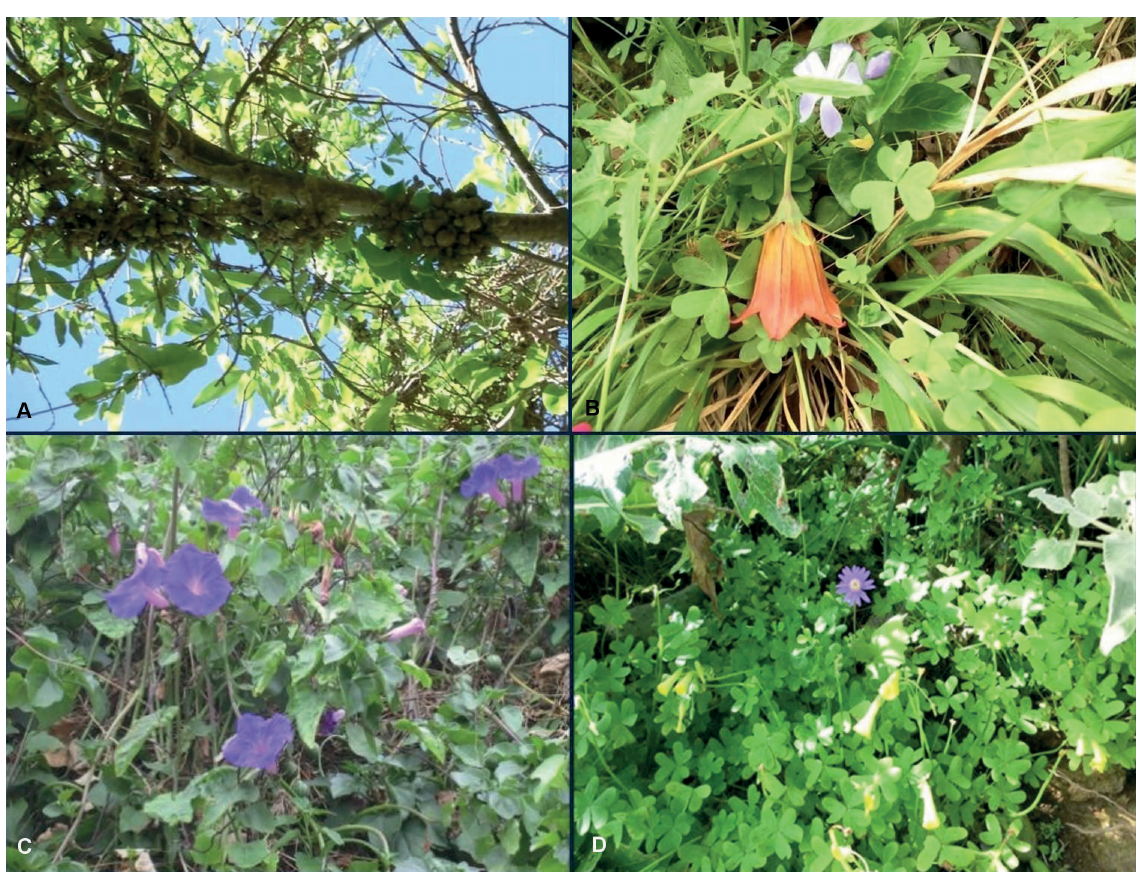
Figure 7 – Invasive exotic species in Anaga Rural Park (Tenerife, Canary Islands): A, aerial tubers of Boussingaultia cordifolia over Canary- Madeira endemic Salix canariensis ; B, Vinca major and Oxalis pes-caprae coexisting with the Canarian endemic Canarina canariensis ; C, Ipomoea indica and Senecio angulatus coexisting with the endemic Bryonia verrucosa (see fruits on the right); D, Oxalis pes-caprae surrounding the endemic Pericallis echinata , apparently competing for water, nutrients and